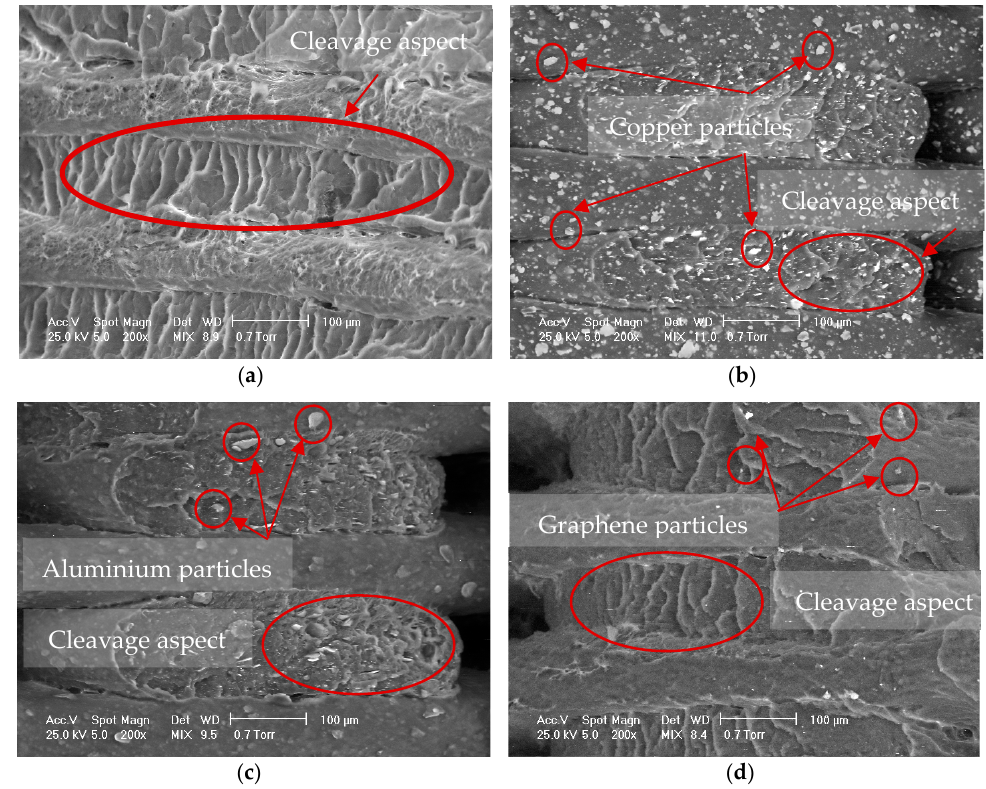
Figure 11. SEM images of the experimental samples, in transversal cross section, with 100% interior fill percentage and 60° thread deposition 3D printing parameters: ( a ) polylactic acid material (PLA); ( b ) polylactic acid material with copper particles (PLA + Cu); ( c ) polylactic acid material with aluminum particles (PLA + Al); ( d ) polylactic acid material with graphene particles (PLA + graphene).